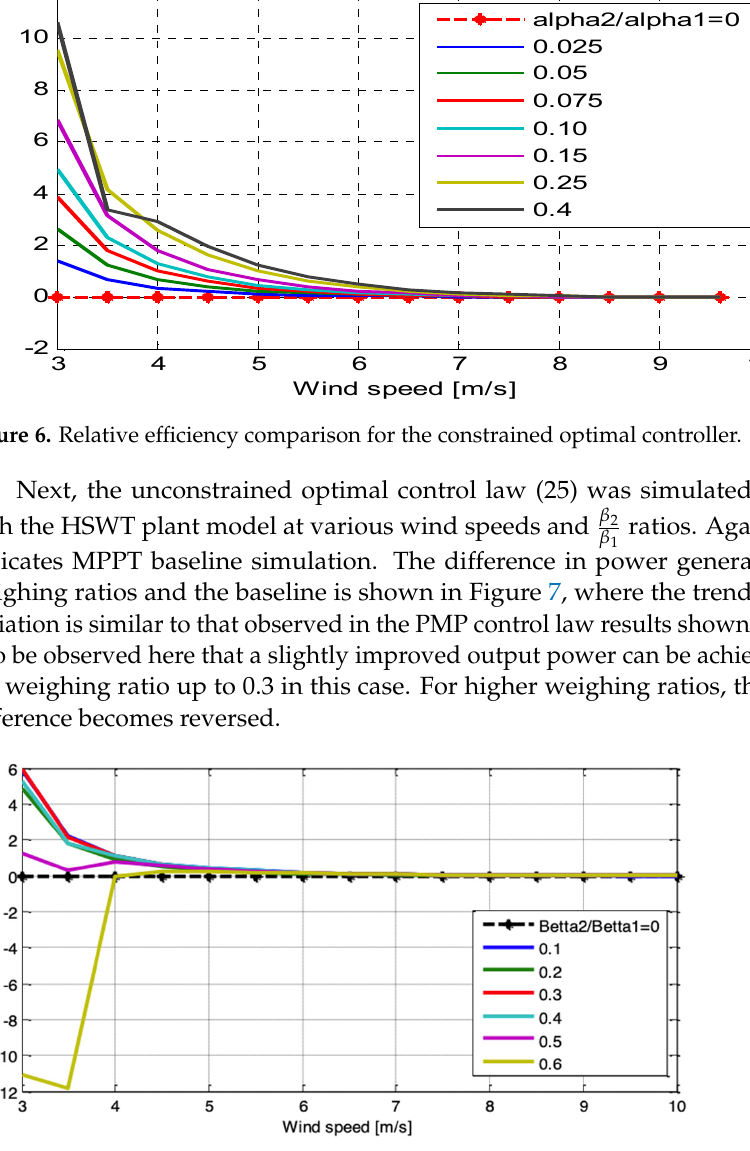
Figure 7. Effect of β 2 β 1 ratios on HSWT output power for unconstrained optimal control. To further compare improvements between the PMP control law (20) and the uncon- strained controller (25), the best weighing ratio for each controller was chosen (in a low speed region). For the PMP control law, the best ratio was 0.1, while for the unconstrained optimal control, the ratio was 0.3. The differences in power output for each controller at their respective best weighing ratios with respect to the MPPT baseline are shown in Fig- ure 8. It can be observed that the output power difference for the optimal controller that minimizes the overall loss (PMP or unconstrained) and the baseline MPPT is positive in low wind-speed regions. At very low wind speeds (3–4 m/s) both constrained and uncon- strained controllers perform about the same. At higher speeds (4–6 m/s) constrained con- troller has a little advantage over unconstrained one. In the wind-speed region of 6–9 m/s, the unconstrained controller offers better results with respect to power output.